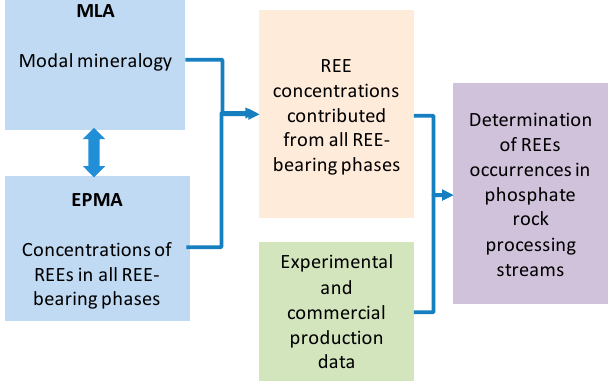
Figure 1. The analytical steps and strategy.